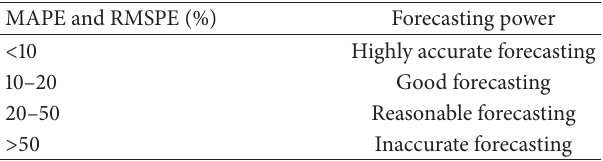
Table 1: Criteria of MAPE and